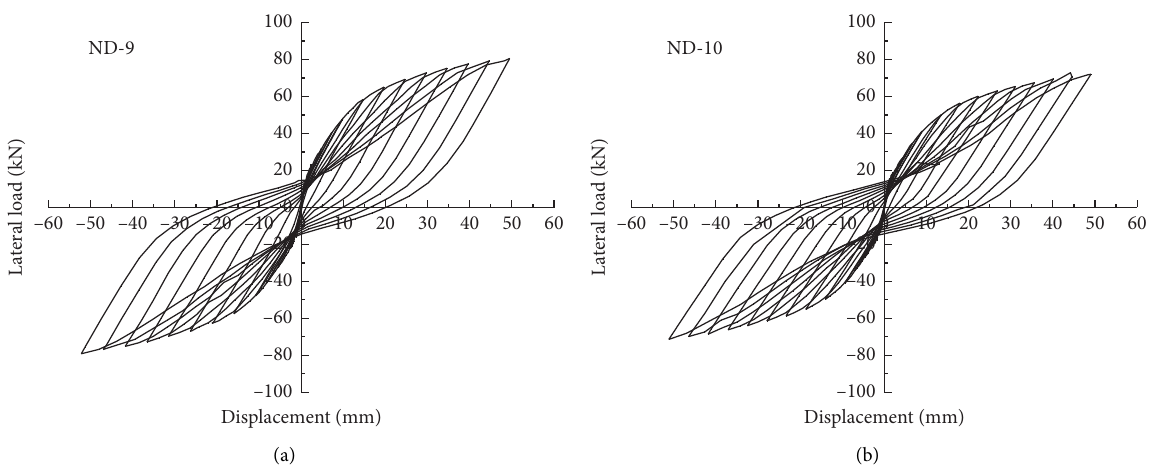
Figure 29: Hysteretic curves of Slit width 40mm. (a) Z -direction constrain. (b) Without constrain.